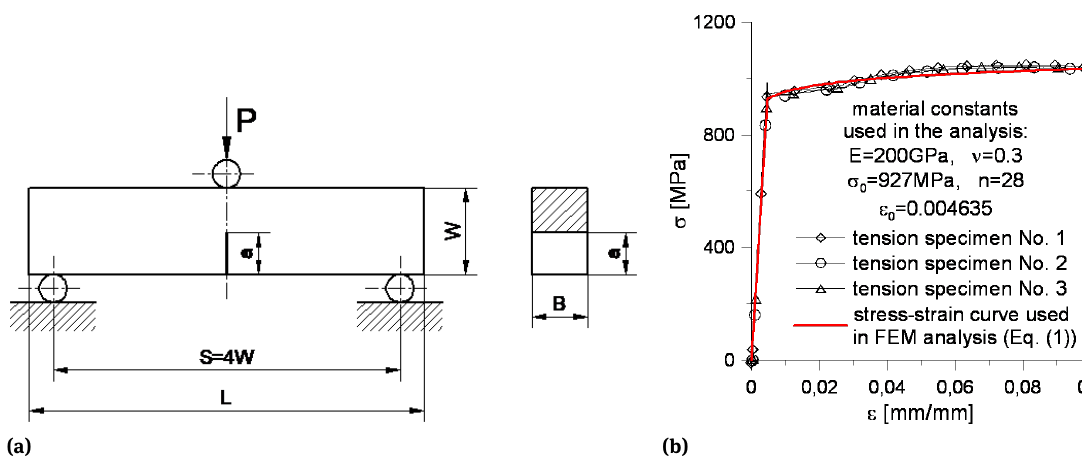
Figure 1: a) The geometry of the SEN(B) specimen used to assess the fracture toughness of 145Cr6 steel; b) Engineering tensile diagrams of 145Cr6 steel, together with the determined values of material constants assumed in further FEM analysis and the stress-strain curve which was used in FEM analysis; (based on [3–5])